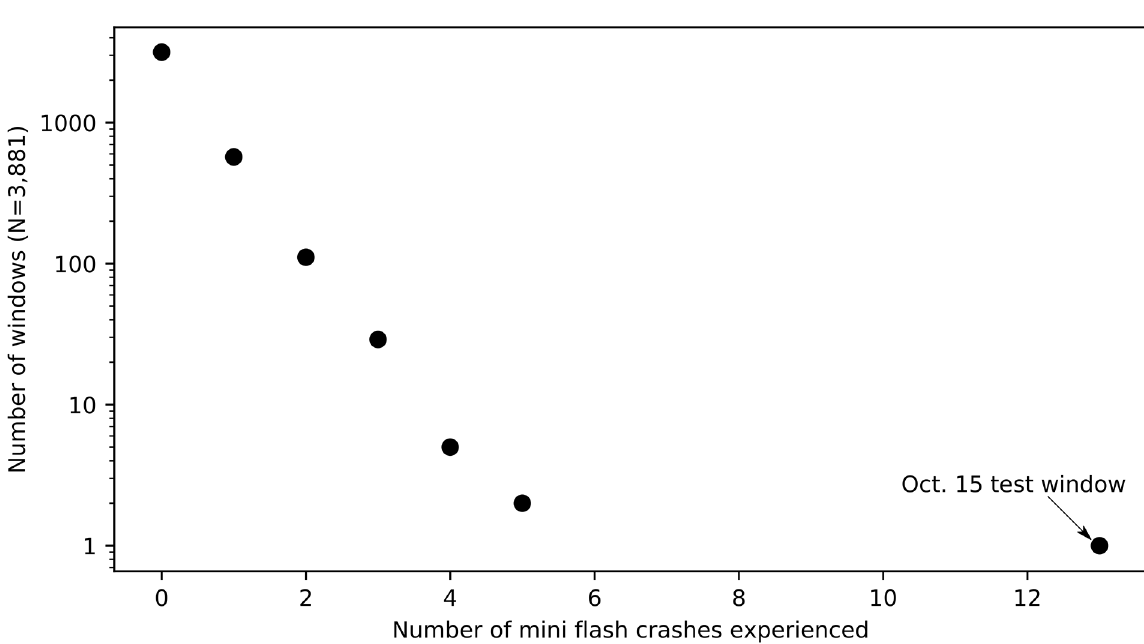
Fig 3. Distribution of number of mini flash crashesper three-minute window. The numberof mini flash crashes during the test windowon Oct. 15 is an extreme outlier. The thirteen mini flash crashes experienced duringthe test windoware more than 2.6 times larger than the number of mini flash crashes experienced duringany other three-minutewindowin ControlPeriod 2.